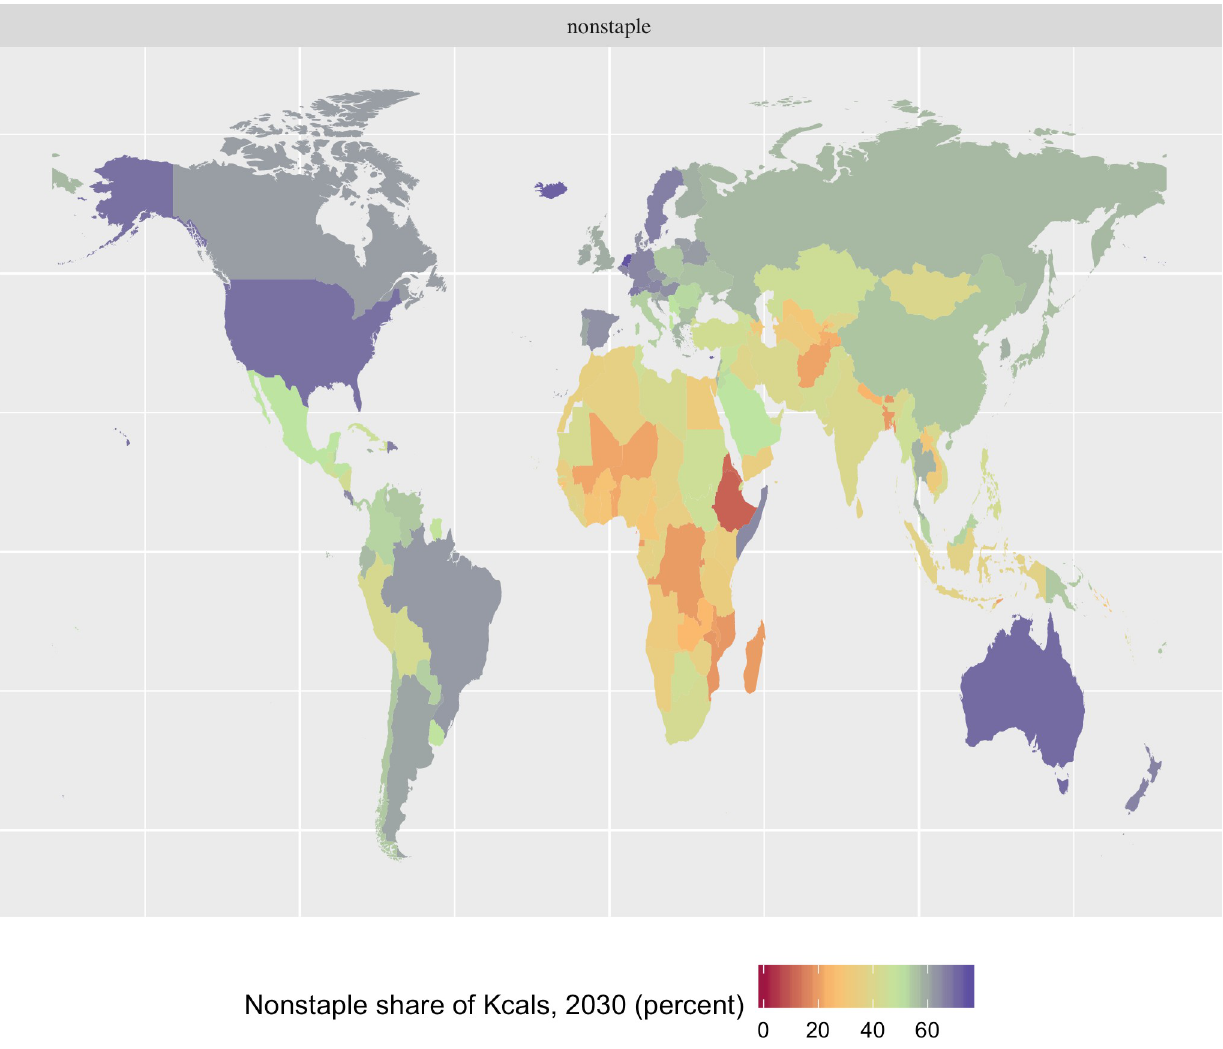
Fig 4. Non-staple share of dietary energy intake in the reference case in 2030 (percent). Source: The authors, based on results from the IMPACT model, using a modeling approach detailed in Nelson et al. [45] with Natural Earth map files (https://www.naturalearthdata.com/) using ggplot2 [47] in R